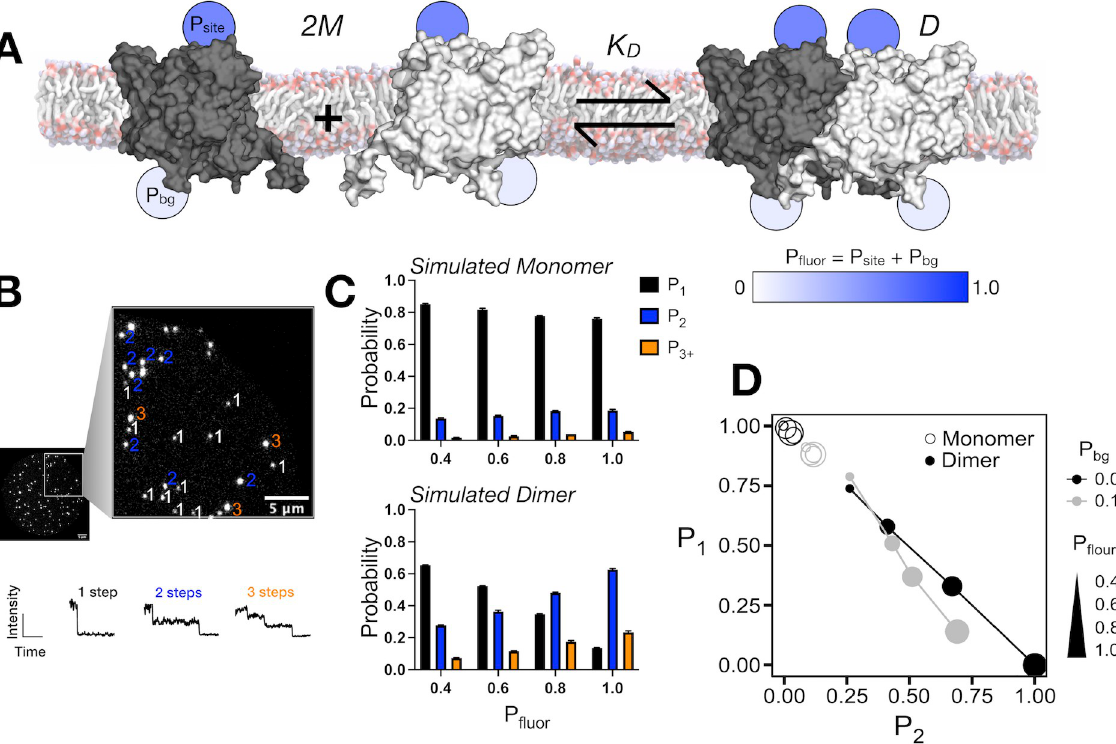
Fig 1. Expected photobleaching probabilities for monomers and dimers at the single-molecule limit. (A) The equilibrium dimerization reaction of two CLC-ec1 monomers ( 2M ) forming a dimer ( D ) in the cellular membrane. In the labeling model, we consider that there is a high probability of labeling at an exposed cysteine site ( P ) and a lower probability of non-specific labeling contributing to the background site ( P ), which is measured in the protein sample without the cysteine. Experimentally the total labeling yield per subunit is measured, P bg P site + P bg for each protein sample. (B) Photobleaching of the fluorophores attached to the protein happens in a step wise fashion when imaged using a TIRF setup. (C) The monomeric and dimeric photobleaching probability distributions for labeling yields with P varied from 0.4 to 1.0, at a single-molecule density of χ rec . = 1 x 10 − 6 subunits/lipid, i.e. << 1 protein species per liposome. Data reported as vs. P photobleaching probabilities showing the dependency of the dimer signal on mean ± SE, for n = 3 simulation replicates. (D) Plot of P 1 2 the labeling yield and overall dynamic range between dimer and